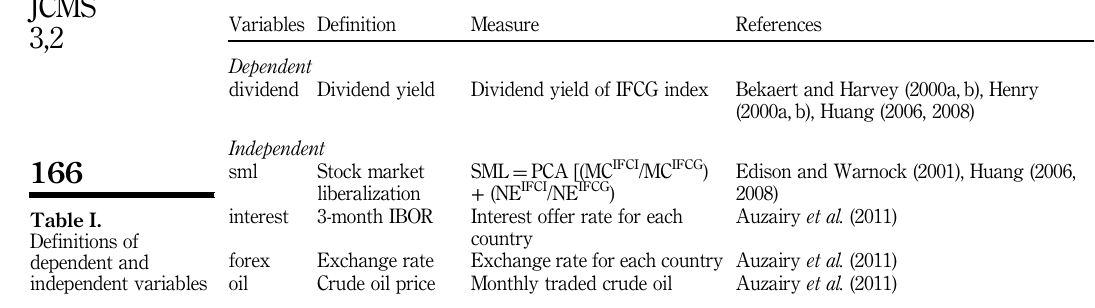
dependent and independent variables